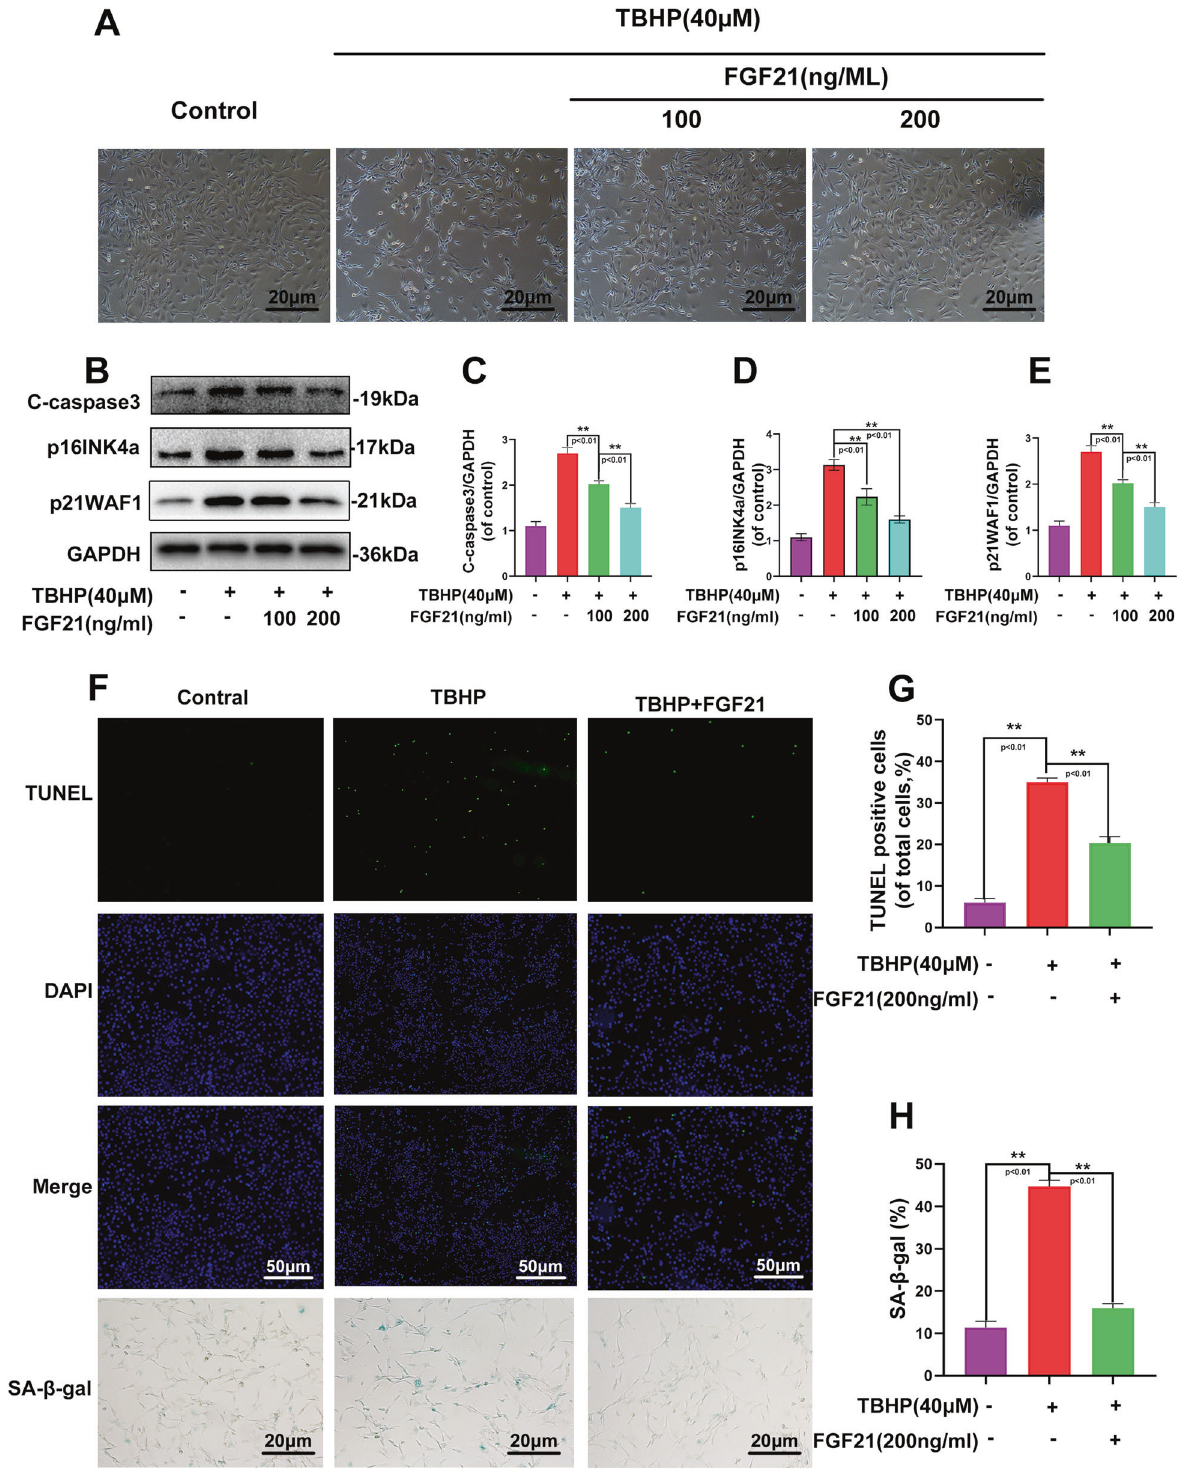
Fig. 1 FGF21 treatment inhibited the apoptosis and senescence of TBHP-induced chondrocytes. A The chondrocytes were pretreated with FGF21 and subsequently with TBHP, and imaged using phase-contrast microscopy (scale bar: 20 μ m). B – E Shown are protein contents of cleaved caspase3, p16INK4a, and p21WAF1 in the chondrocytes treated with TBHP and TBHP plus FGF21. F – H TUNEL assay and SA- β -gal staining assay were performed in the chondrocytes as treated above (scale bar: 50 μ m). The data in the fi gures are the averages ± S.D. Signi fi cant differences between the treatment and control groups are indicated as ** P < 0.01 and * P < 0.05, n =